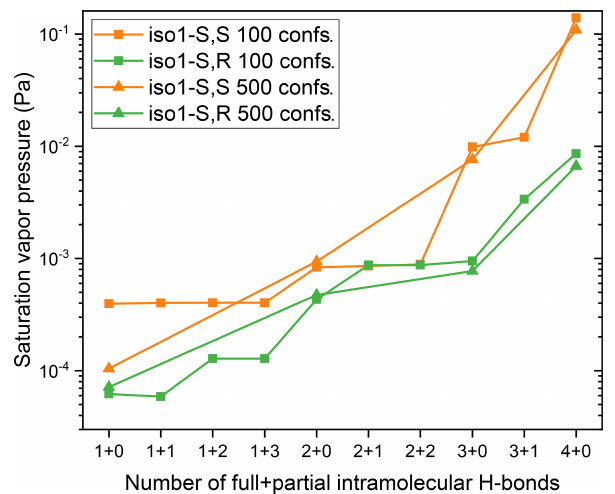
Figure 5. Saturation vapor pressures, at 298.15K, of the S,S and S,R stereoisomers of structural isomer 1 of the dihydroxy dihydroperoxide C 5 H 12 O 6 , calculated using COSMOtherm ver- sion 18 and the BP_TZVPD_FINE_18 parameterization (based on BP/def2-TZVPD//BP/def-TZVP quantum chemical data), includ- ing only conformers with less than n + m full and partial H-bonds (e.g., where “1 + 3” indicates one full and three partial H-bonds) and using either 100 or 500 conformers in the original conformer pool. For the calculations with 100 overall conformers, all gas- phase geometries were visually inspected, and the optimized gas- phase energy was replaced with a single-point gas-phase energy at the COSMO geometry whenever the optimized gas-phase structure had a different number of H-bonds than the COSMO structure. For the calculations with 500 overall conformers, the 100 lowest-energy gas-phase structures in each H-bond-restricted conformer subset were similarly inspected. In addition, duplicate gas-phase conform- ers within 10kJmol − 1 of the lowest-energy optimized gas-phase structure were replaced with single-point gas-phase energies at the COSMO geometries. See Sect. S5 in the Supplement file for further details and discussion on gas-phase conformer